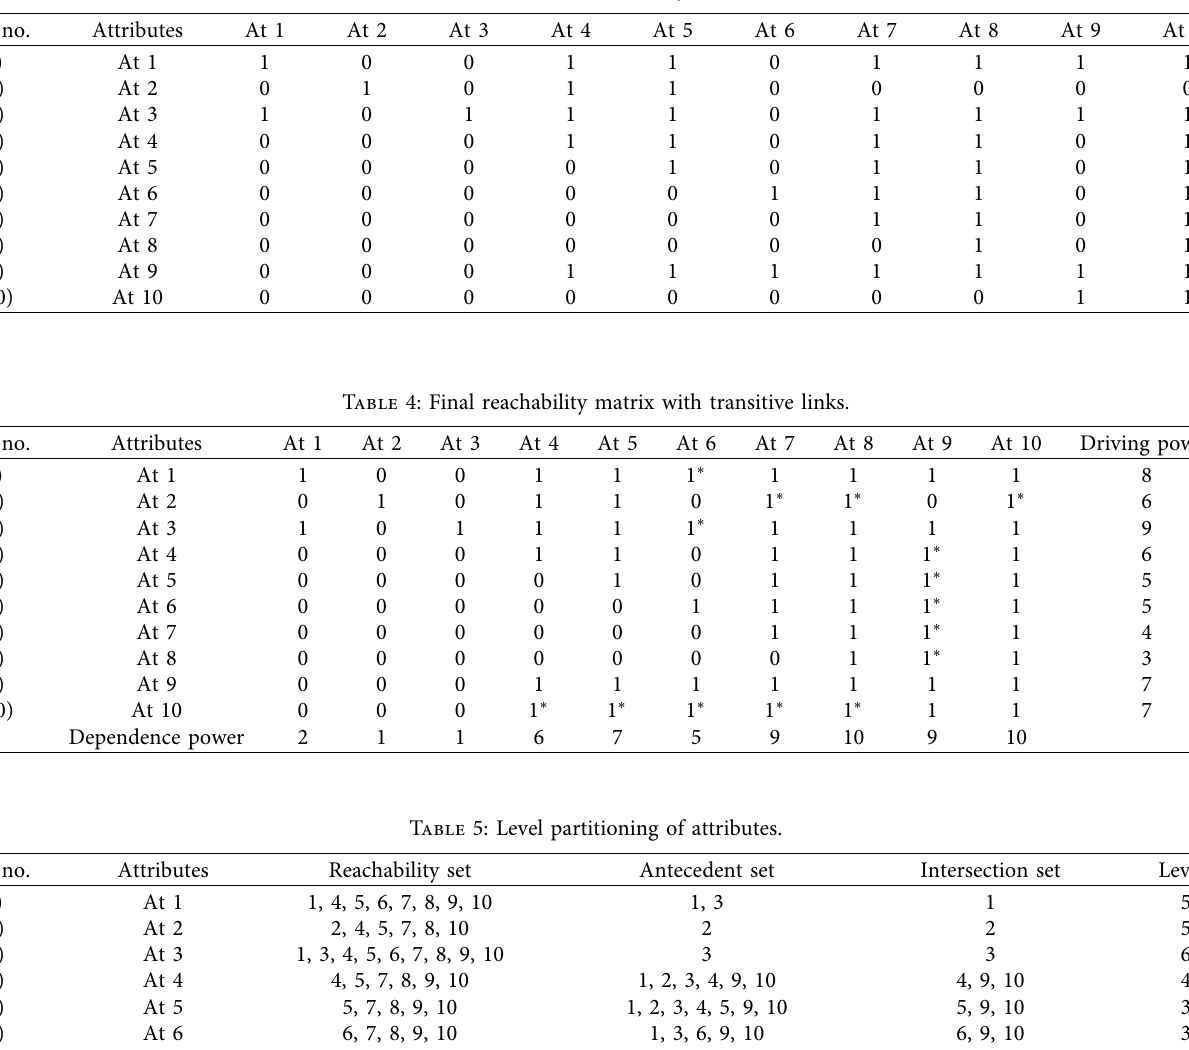
Table 3: Initial reachability matrix.